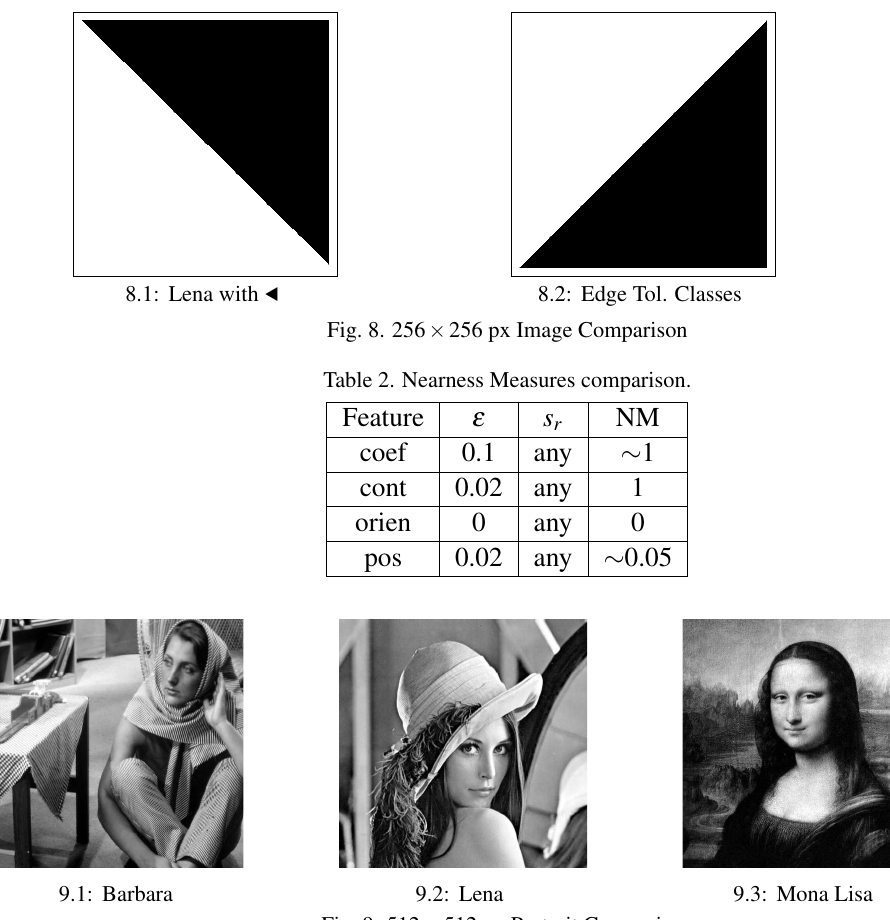
Fig. 9. 512 × 512 px Portrait